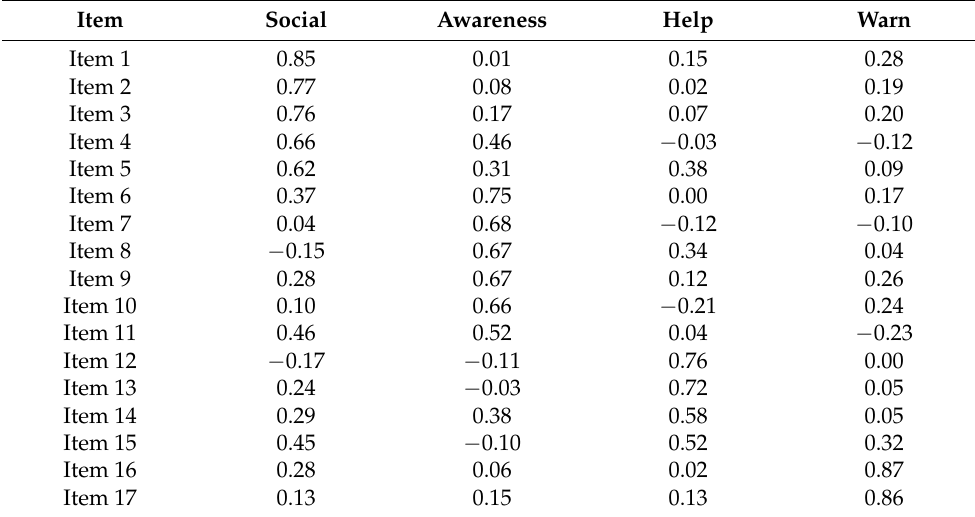
Table 2. Exploratory Factor Analysis rotated factor